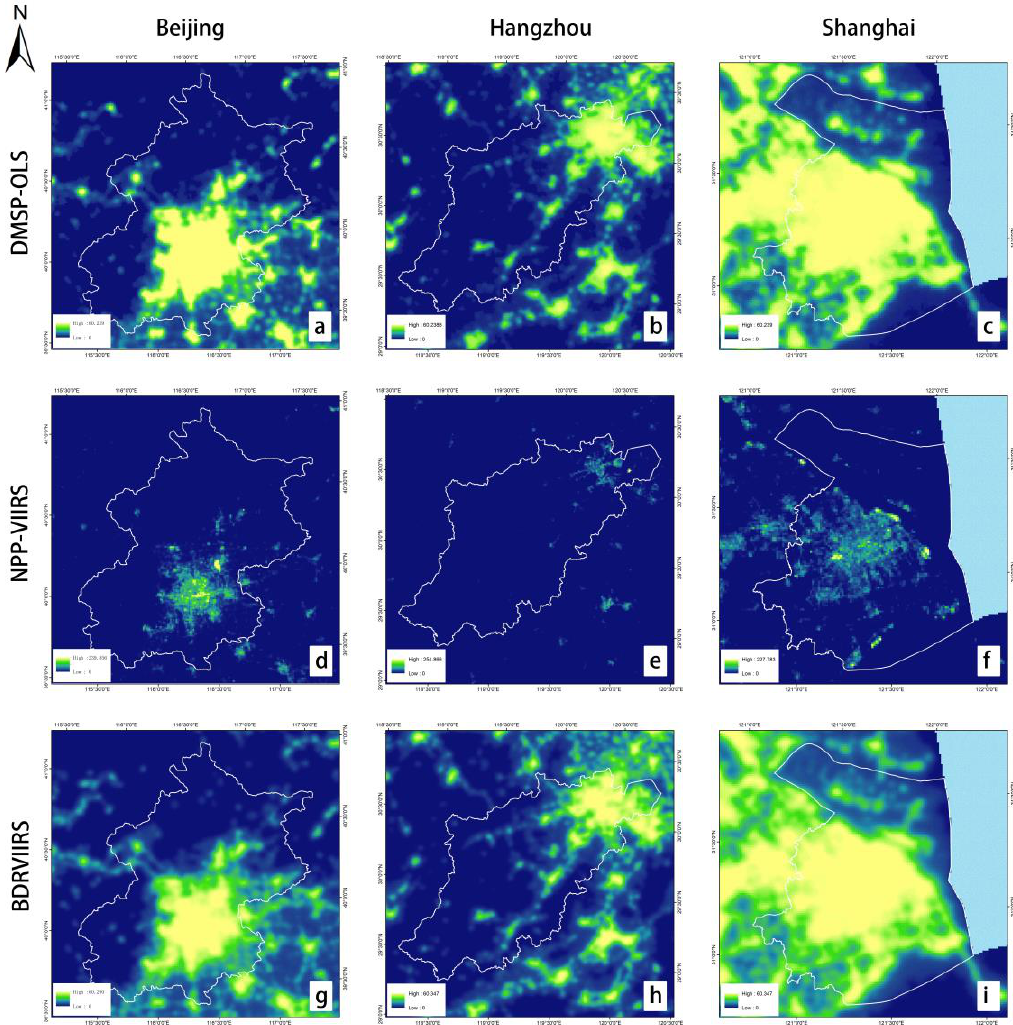
Figure 8. DMSP-OLS images in the cities of Beijing, Hangzhou and Shanghai (a, b, and c); NPP-VIIRS images in the three cities (d, e, and f); BDRVIIRS images of the three cities (g, h, and i).